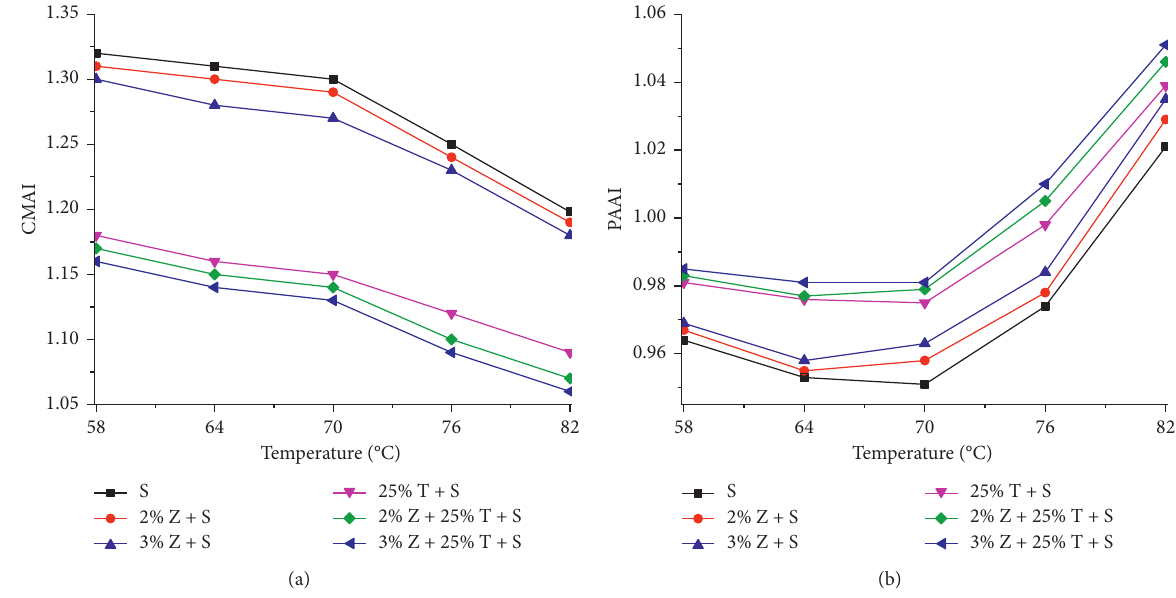
Figure 3: Effect of different amounts of nano-ZnO (Z) and TLA (T) on rheological properties of SBS asphalt (S) after short-term aging. (a) Complex modulus aging index for asphalt. (b) Phase angle aging index for asphalt.